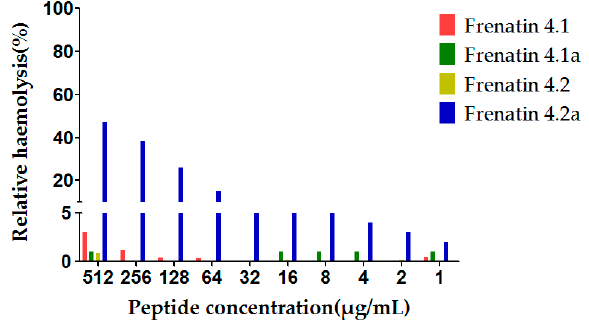
Figure 6. Relative haemolysis of the frenatin 4.1, 4.2 and their analogues. The 100% haemolysis was defined using haemolytic effect induced by 1% TritonX-100 (Sigma-Aldrich, St. Louis, MO, USA).